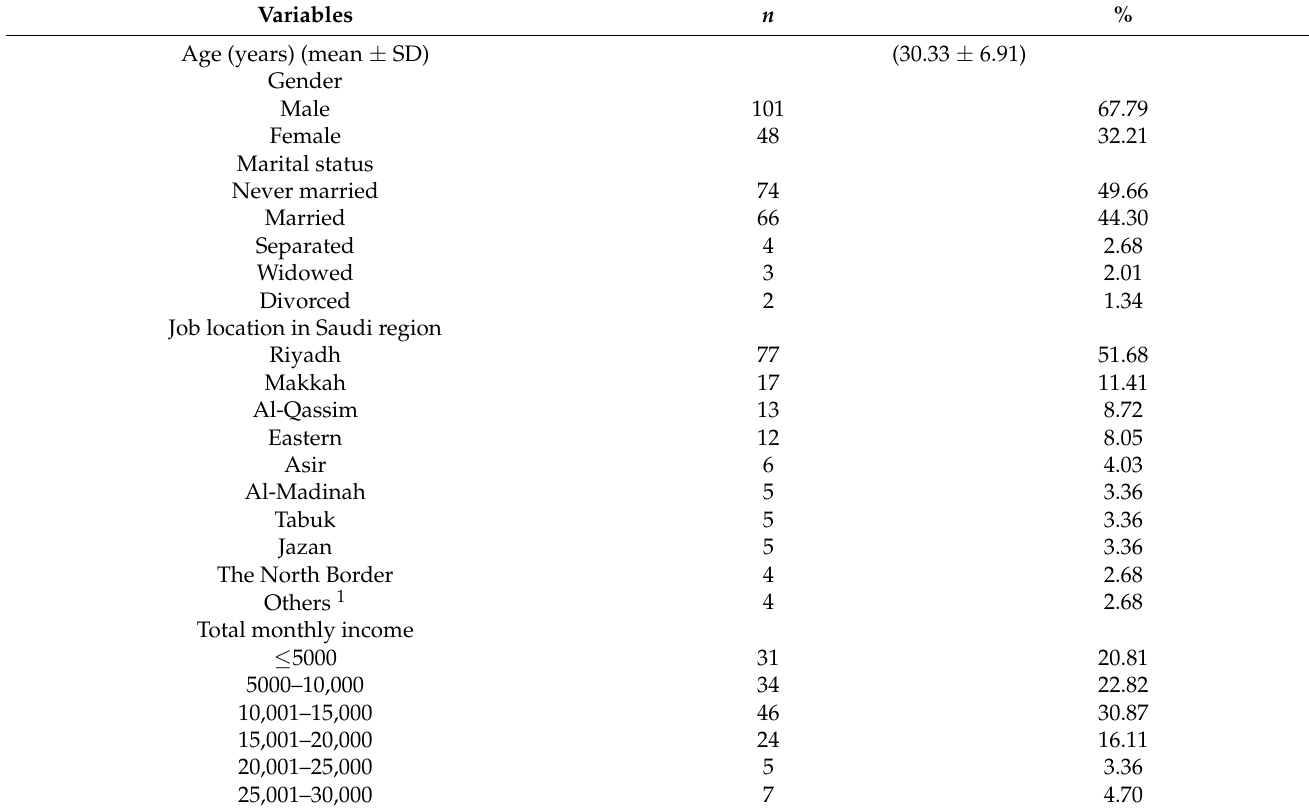
Table 1. Participant sociodemographic and pharmacy practice characteristics ( n =